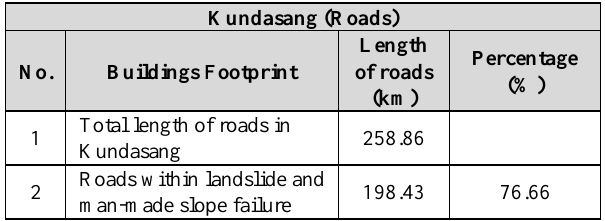
Table 8. Statistics of selcted roads within 100 meters distance in Kundasang